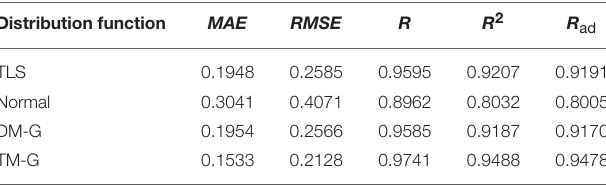
TABLE 7 | Fitting index value of probability density distribution of Xichang data on August 9, 2018. Distribution